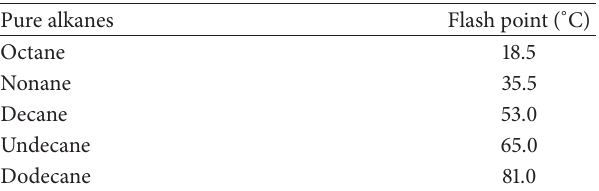
Table 2: Flash points of the pure alkanes.